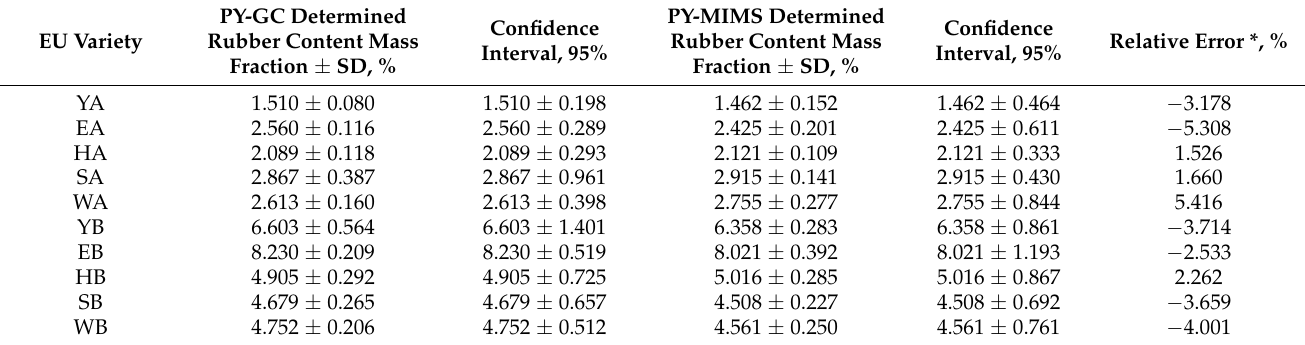
Table 1. Comparison of Rubber Content in Samples by PY-GC and PY-MIMS.